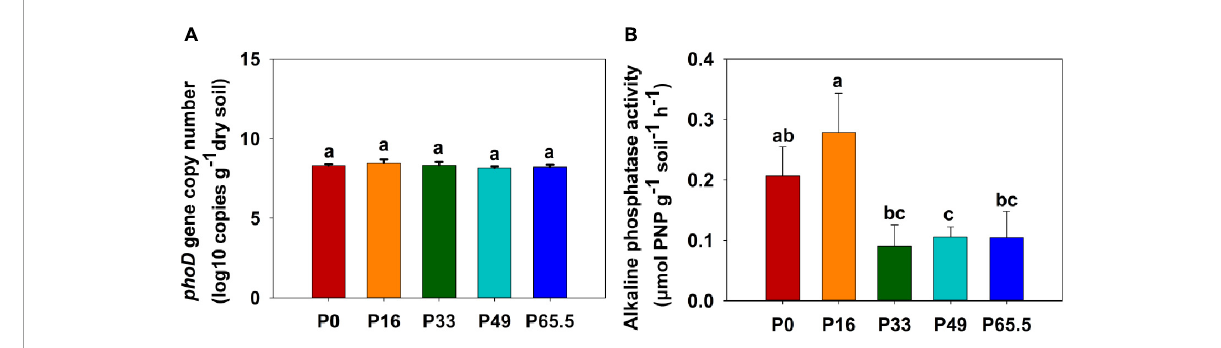
FIGURE2 phoD gene abundance (A) and alkaline phosphatase (ALP) (B) in soils treated with five phosphorus fertilization rates. Small letters indicate a significant difference ( P < 0.05 after the Duncan test) between P levels. P0, P16, P33, P49, and P65.5 represent 0, 16, 33, 49, and 65.5 kg P ha − 1 ,